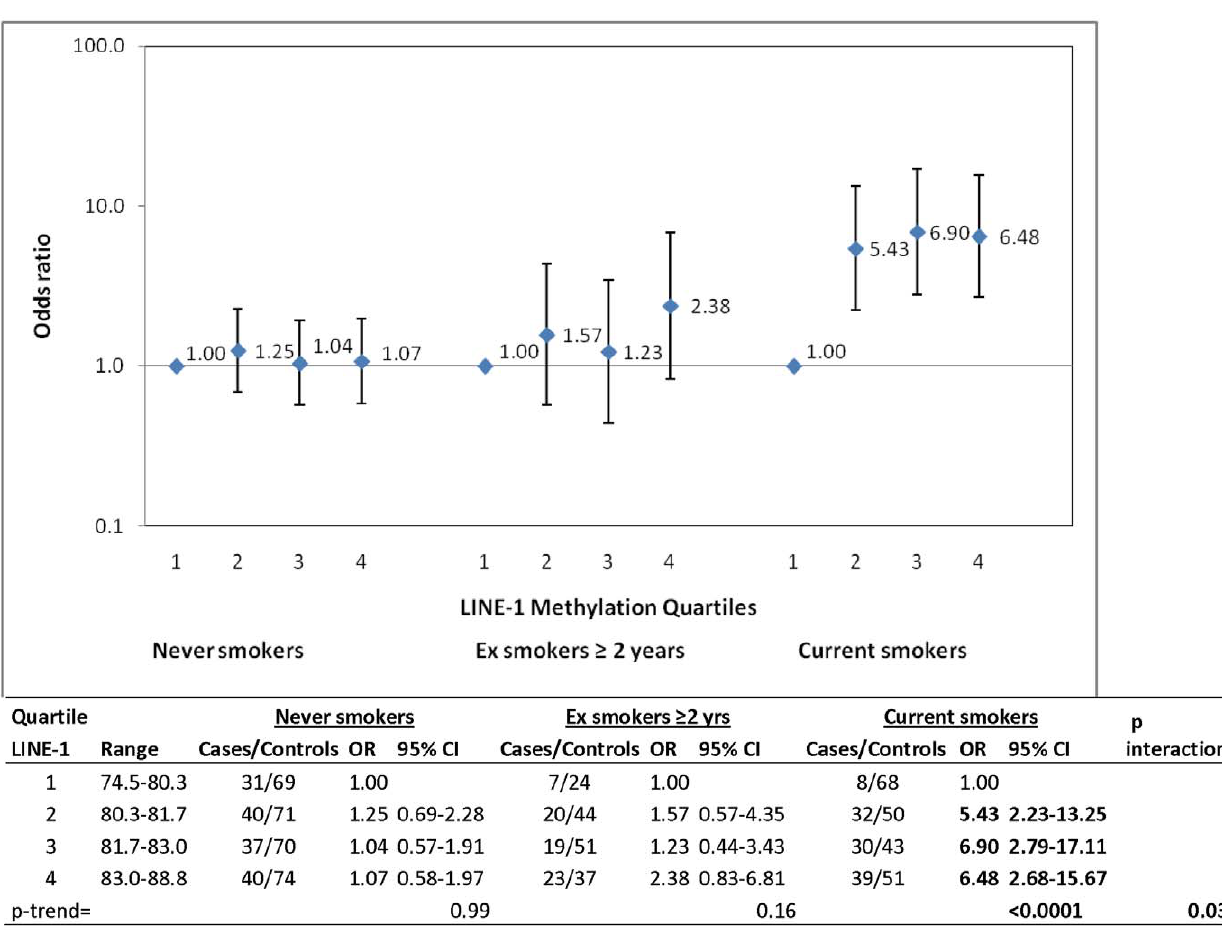
Figure 1. Association between LINE-1 methylation levels and risk of RCC stratified by smoking status. Odds ratios and 95% confidence intervals for the association between LINE-1 methylation levels and RCC, adjusted for sex, age, center, BMI, high blood pressure and vegetable intake.